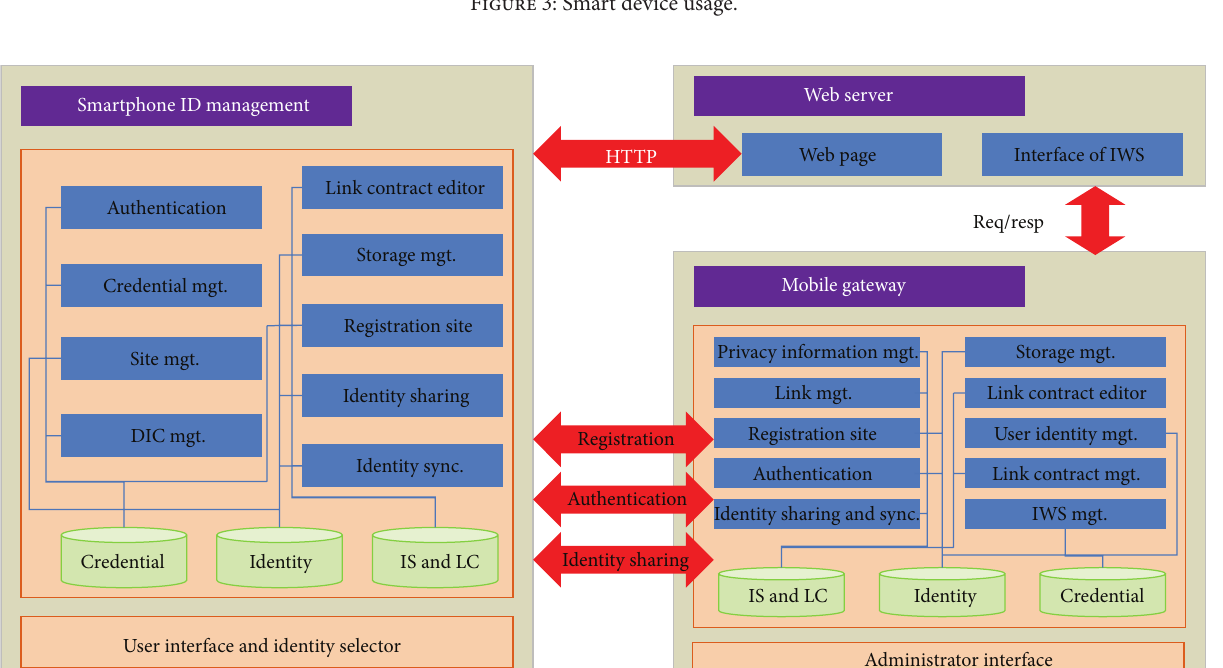
Figure 3: Smart device usage.